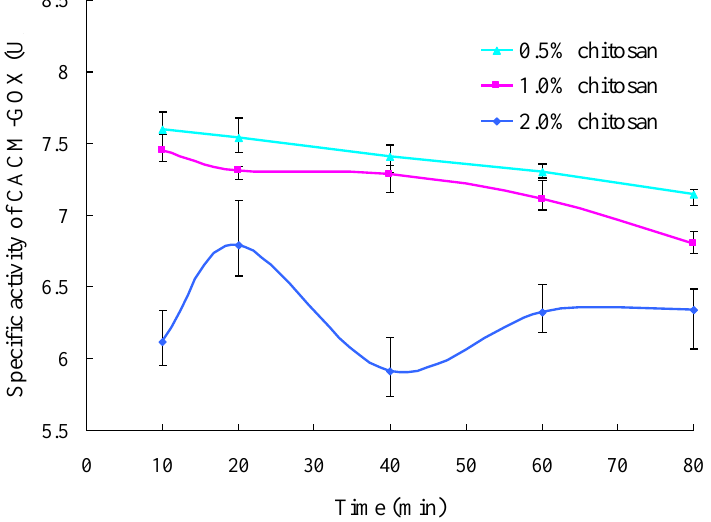
Figure 7. Effect of encapsulation time on specific GOX activity. The specific activity of CACM-GOX is the ratio of total activity of CACM-GOX to encapsulation